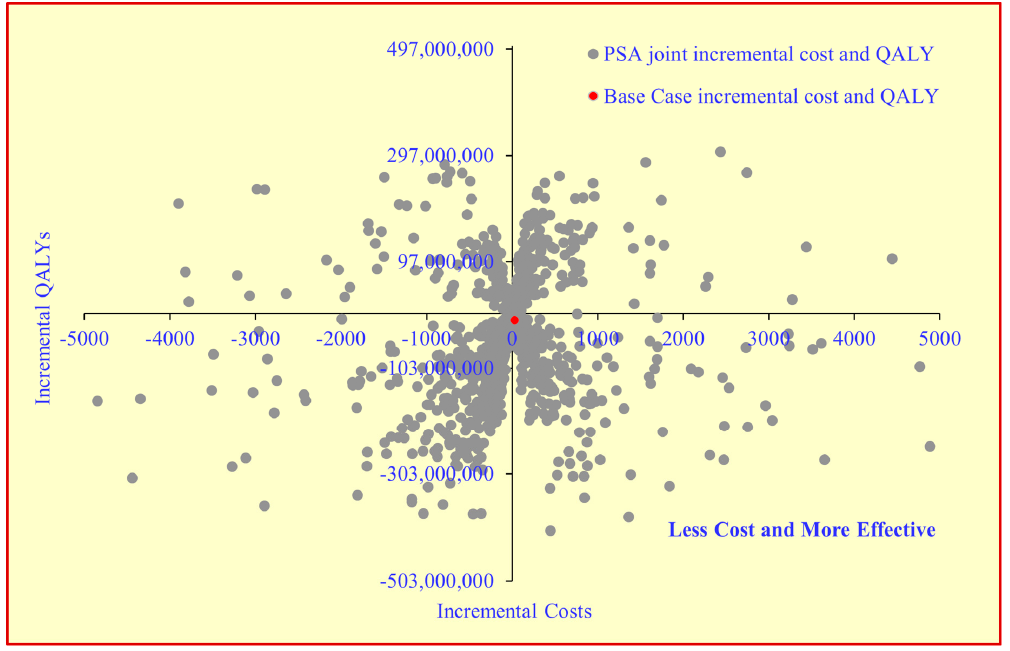
Figure 3. The cost-effectiveness plane for the impact of joint uncertainty of all the input parameters on ICER value. PSA—Probability sensitivity analysis, QALY—Quality adjusted life